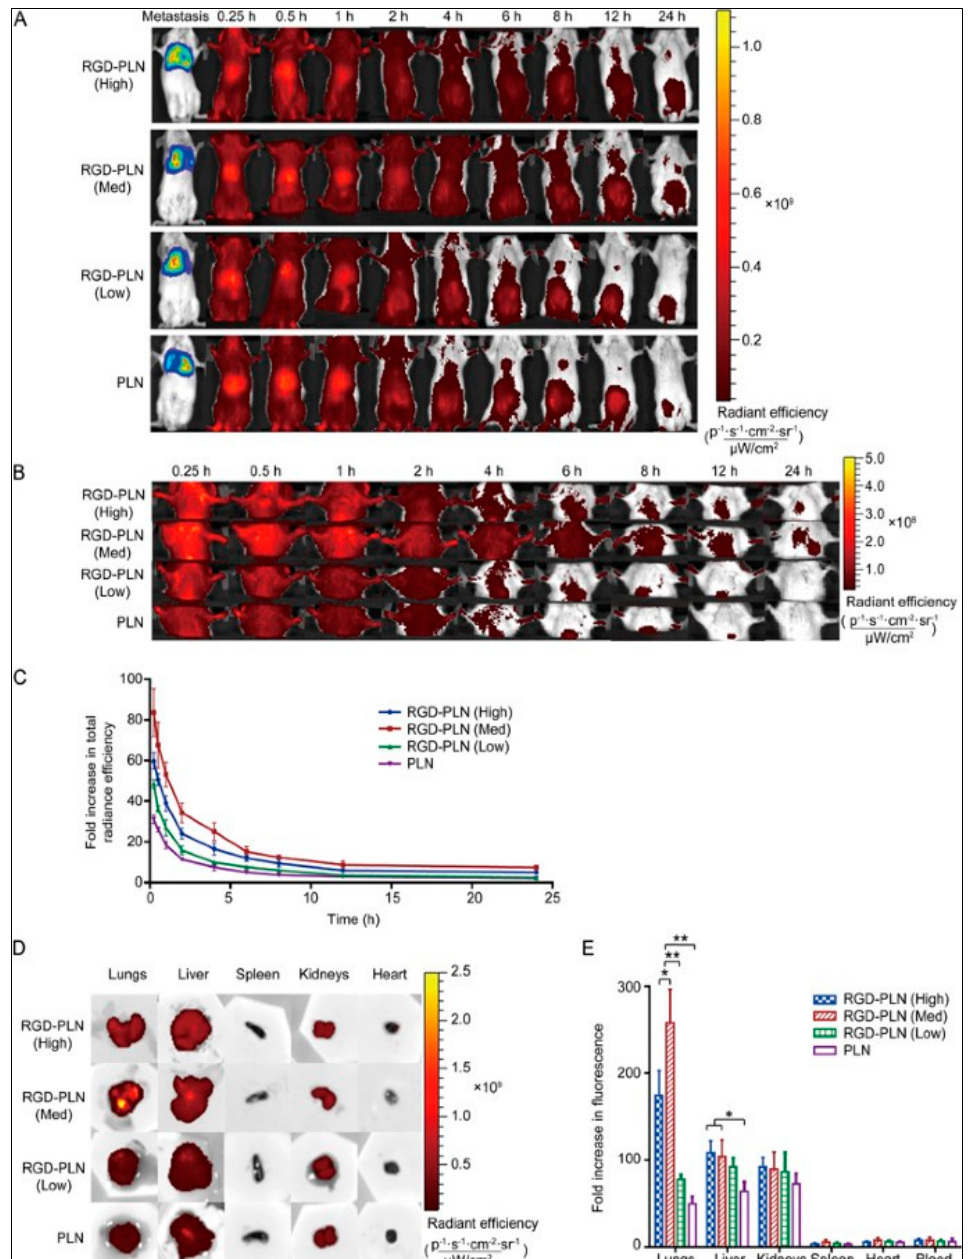
Figure 8. Fluorescent imaging of ICG labeled DOX-MMC-NP biodistribution in the MDA-MB 231-luc-D3H2LN lung metastasis SCID model of TNBC. ( A ) Biodistribution images of the whole body upto 24 h through Xenogen IVIS Spectrum System 100 with Ex: 745 nm and Em: 820 nm. ( B ) Mag- nified images of NPs accumulation in the lungs for 24 h. ( C ) A quantitative representation of DOX- MMC-NP biodistribution in lung metastatic region up to 24 h. ( D ) Qualitative representation of DOX-MMC-NP biodistribution in various organs ex vivo for 4 h. ( E ) Quantitative representation of DOX-MMC-NP biodistribution in various organs ex vivo for 4 h (* p < 0.05, ** p < 0.01). This work is licensed under the Creative Commons Attribution-Non-Commercial-No Derivative Works 3.0